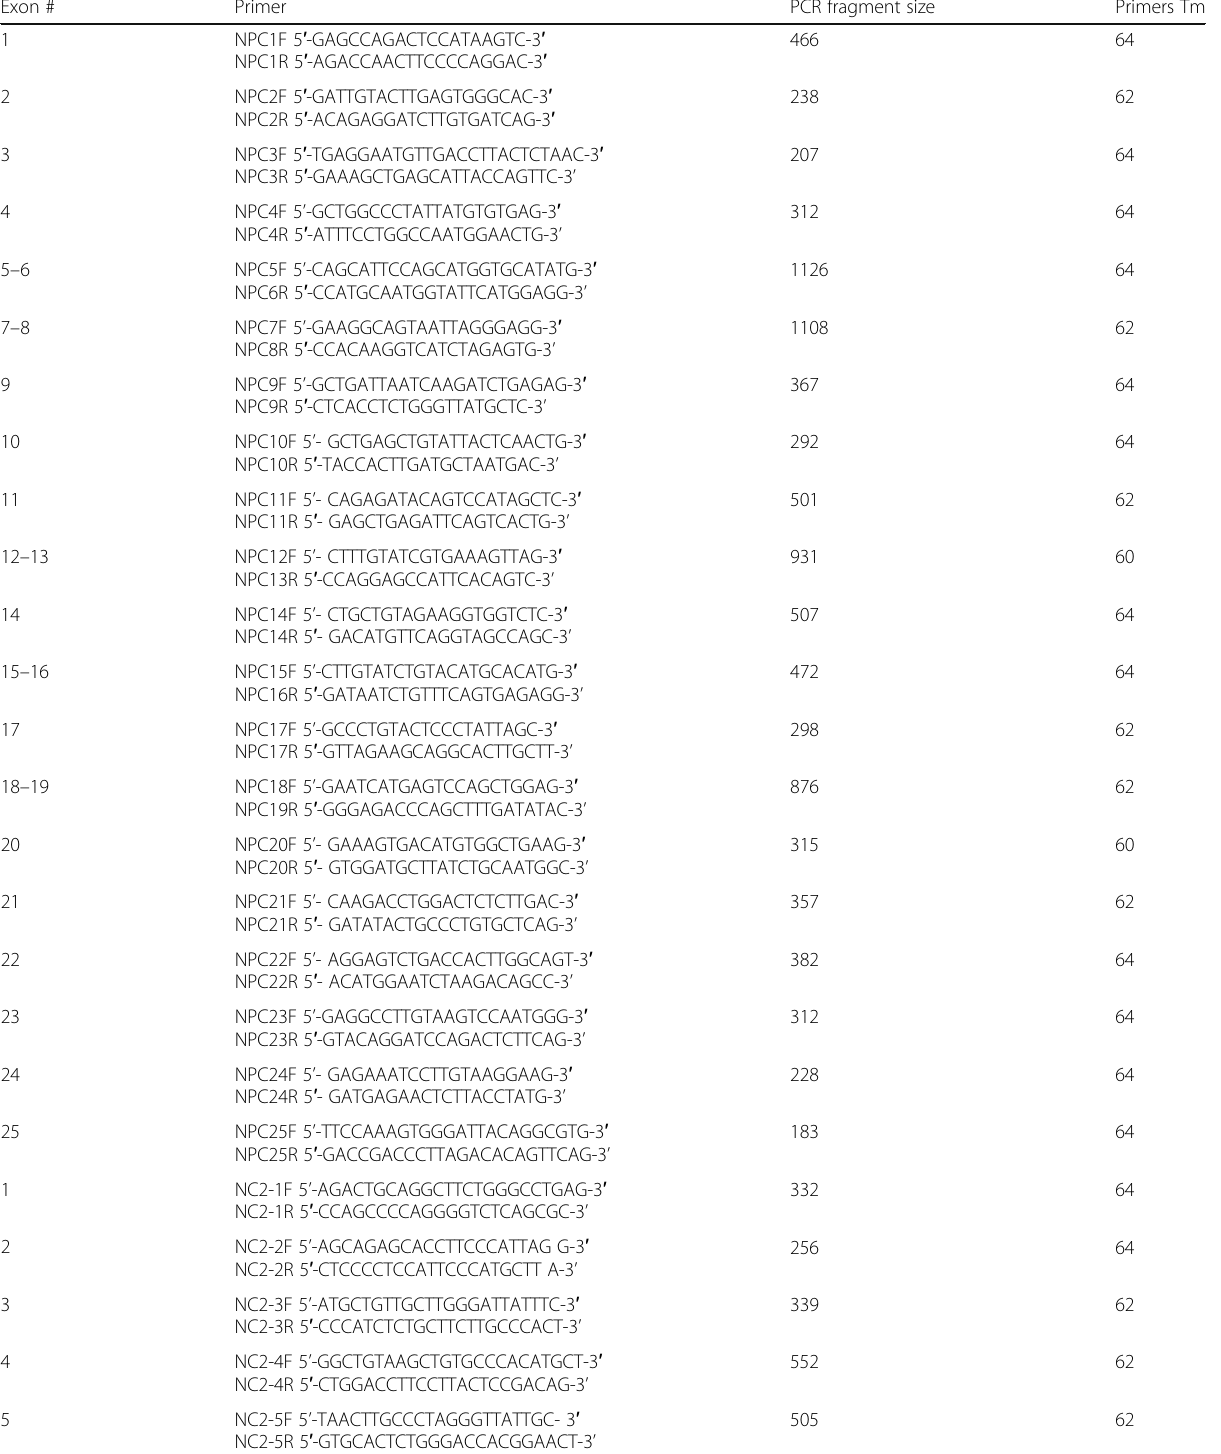
Table 2 Primers for PCR amplification and Sanger-sequencing of exons and flanking regions of NPC1 and NPC2